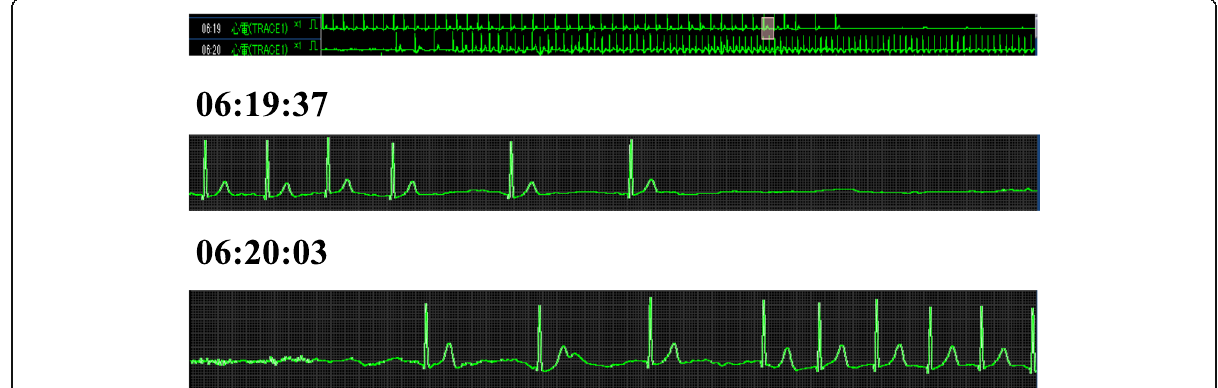
Fig. 1 Electrocardiogram recorded in the ward 17 hours and 14 minutes after surgery. Trend recording during the first episode of bradycardia (top), at the onset of bradycardia and cardiac arrest (middle) and spontaneous recovery approximately in 23 s